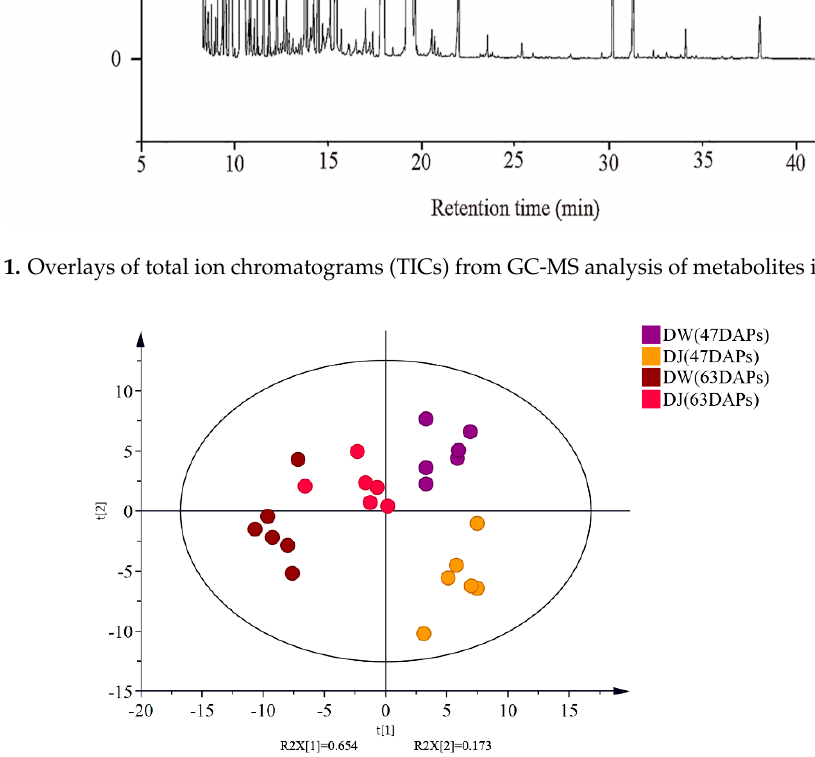
Figure 2. Principle component analysis (PCA) of the primary metabolites derived from GC-MS data.